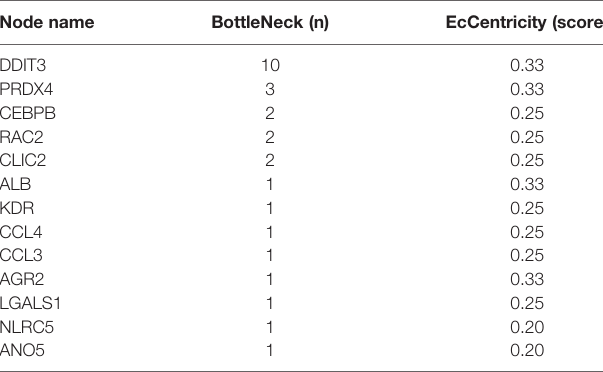
TABLE 1 | Intersection genes evaluated by BottleNeck and EcCentricity in the